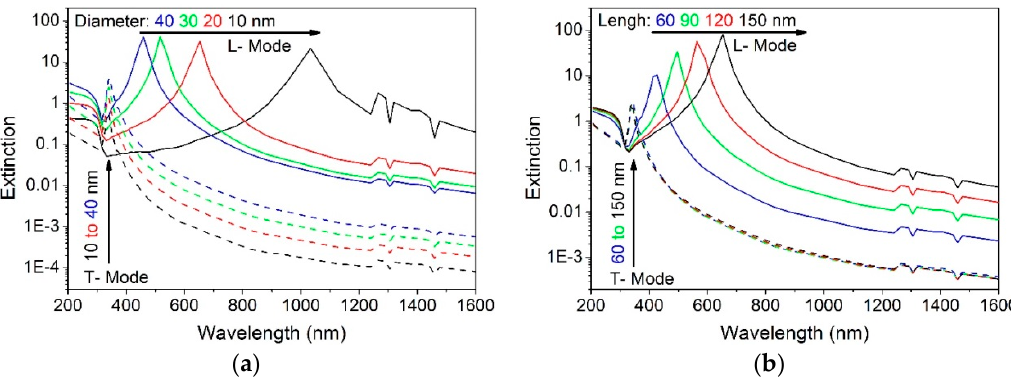
Figure 12. The calculated extinction spectra of the plasmonic nanopolarizer. ( a ) The nanorod with a fixed length of 100 nm and different diameters (e.g., 10, 20, 30, and 40 nm); ( b ) The nanorod with a fixed length of 100 nm and di ff erent diameters (e.g., 10, 20, 30, and 40 nm); ( b ) The nanorod with a constant diameter of 30 nm and different lengths (e.g., 150, 120, 90, and 60 nm). constant diameter of 30 nm and di ff erent lengths (e.g., 150, 120, 90, and 60 10 log( ) I I × 0 , t z